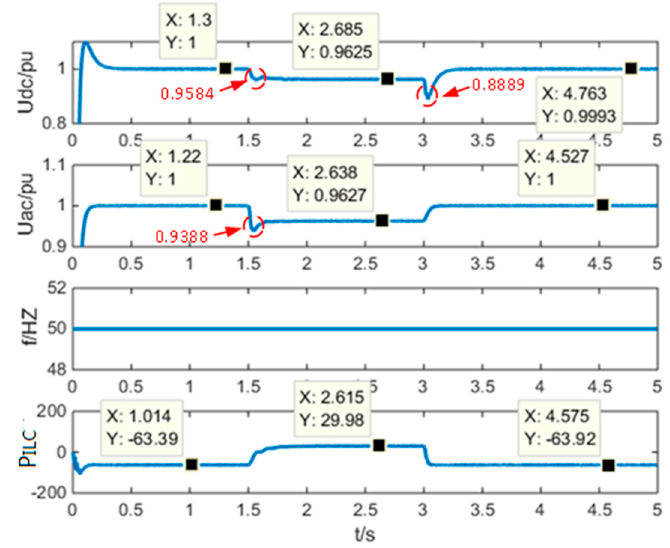
Figure 18. DC voltage, AC voltage, frequency, and ILC transmission power (DC load = 112.5 kW; AC load = 120 kW).